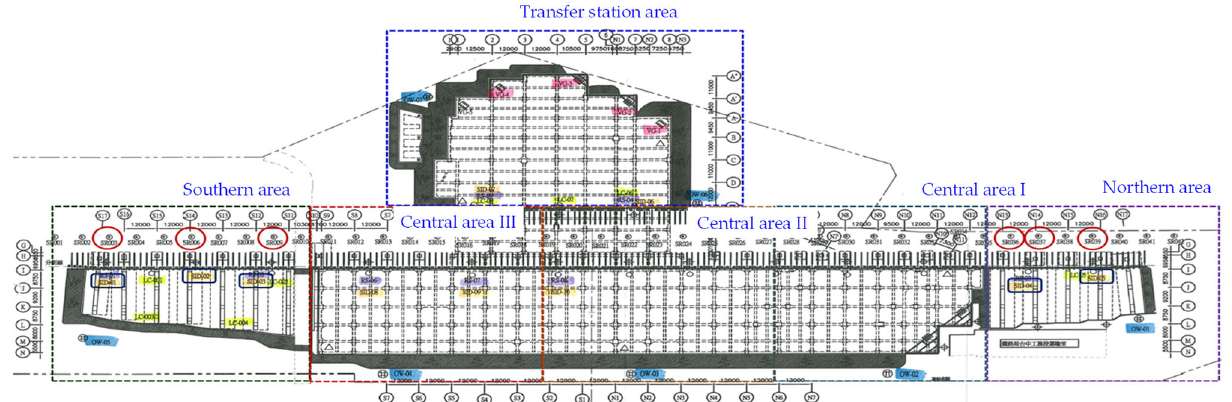
Figure 4. Distribution map of the monitoring equipment installed in the